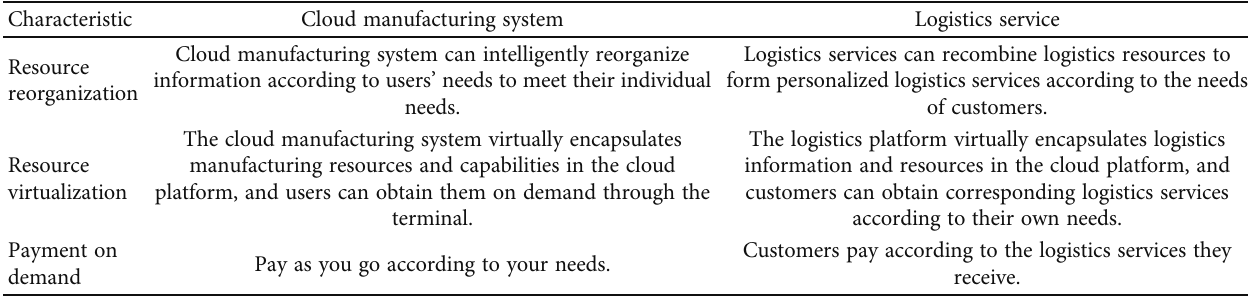
Table 1: Comparison of cloud manufacturing systems and logistics